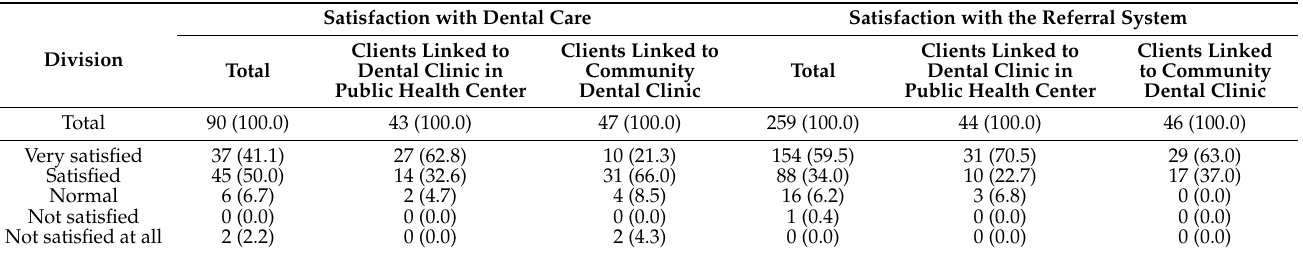
Table 4. Satisfaction with dental care through the NCDs preventive management project.